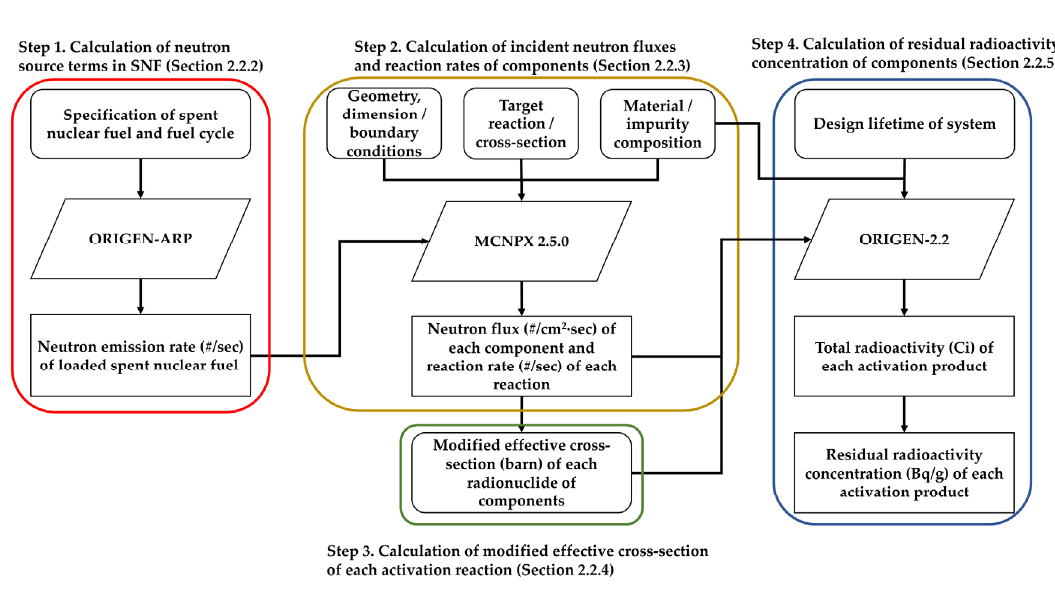
Figure 2. Overall neutron activation analysis framework established in this study.